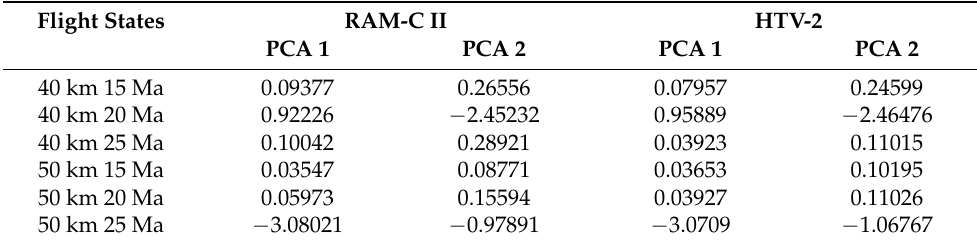
Figure 5. Extracted PCA features. Table 1. The value of extracted PCA features.